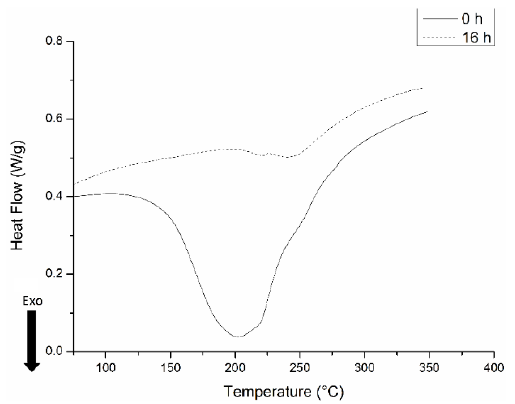
Figure 4. Differential scanning calorimetry (DSC) thermogram of sample 5050DDM, before and after 16 curing hours.